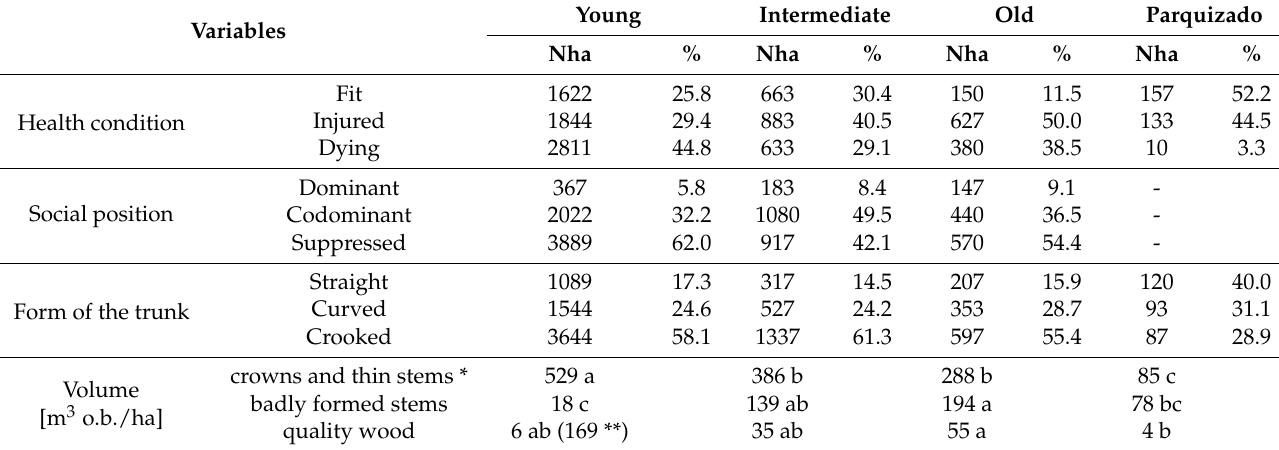
Figure 5. Number of stems to extract and to remain in the thinning simulation per diameter class. Left : young, centre : intermediate, and right : old stands; the ordinates are differently scaled because otherwise, the charts with low number of stems/ha (intermediate and old stands) would not be readable.